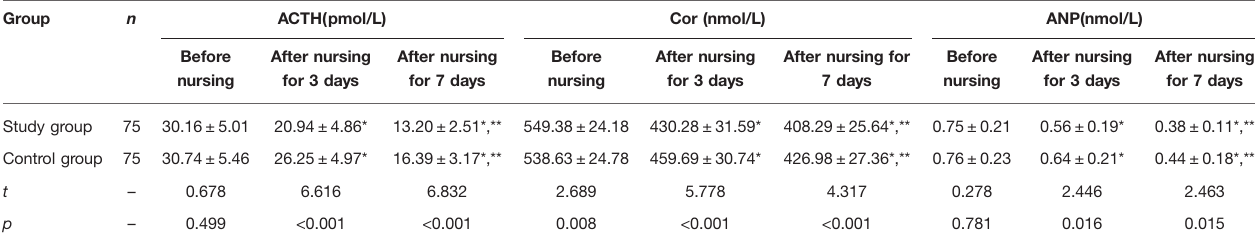
TABLE 2 | Comparison of ACTH, Cor, and ANP levels between two groups of children before and after nursing ( (cid:1) x + s). Group